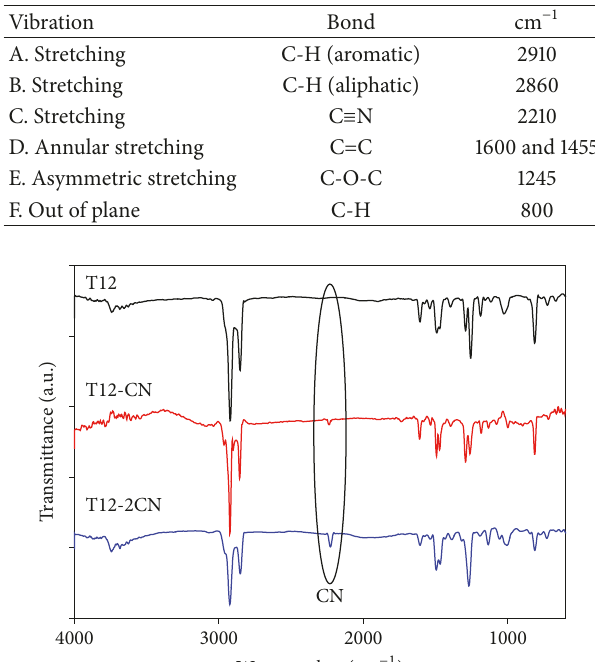
Table 1: FTIR bands of terphenyls as identified elsewhere [17–27].